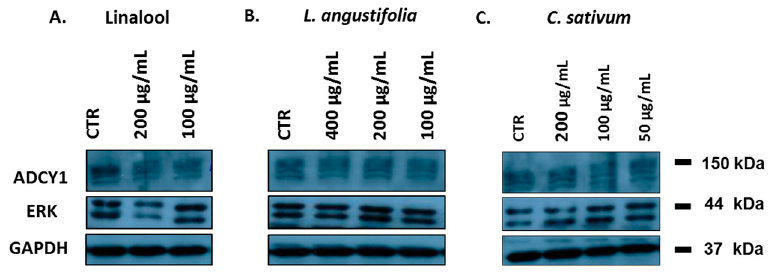
Figure 2. Representative Western blot of ADCY1 and ERK protein in SH-SY5Y treated with linalool ( A ); L. angustifolia essential oil ( B ); C. sativum essential oil ( C ).